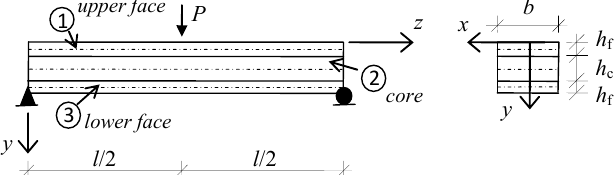
Figure 3. Simply supported composite sandwich beam case study: Geometry, constraining and loading conditions.